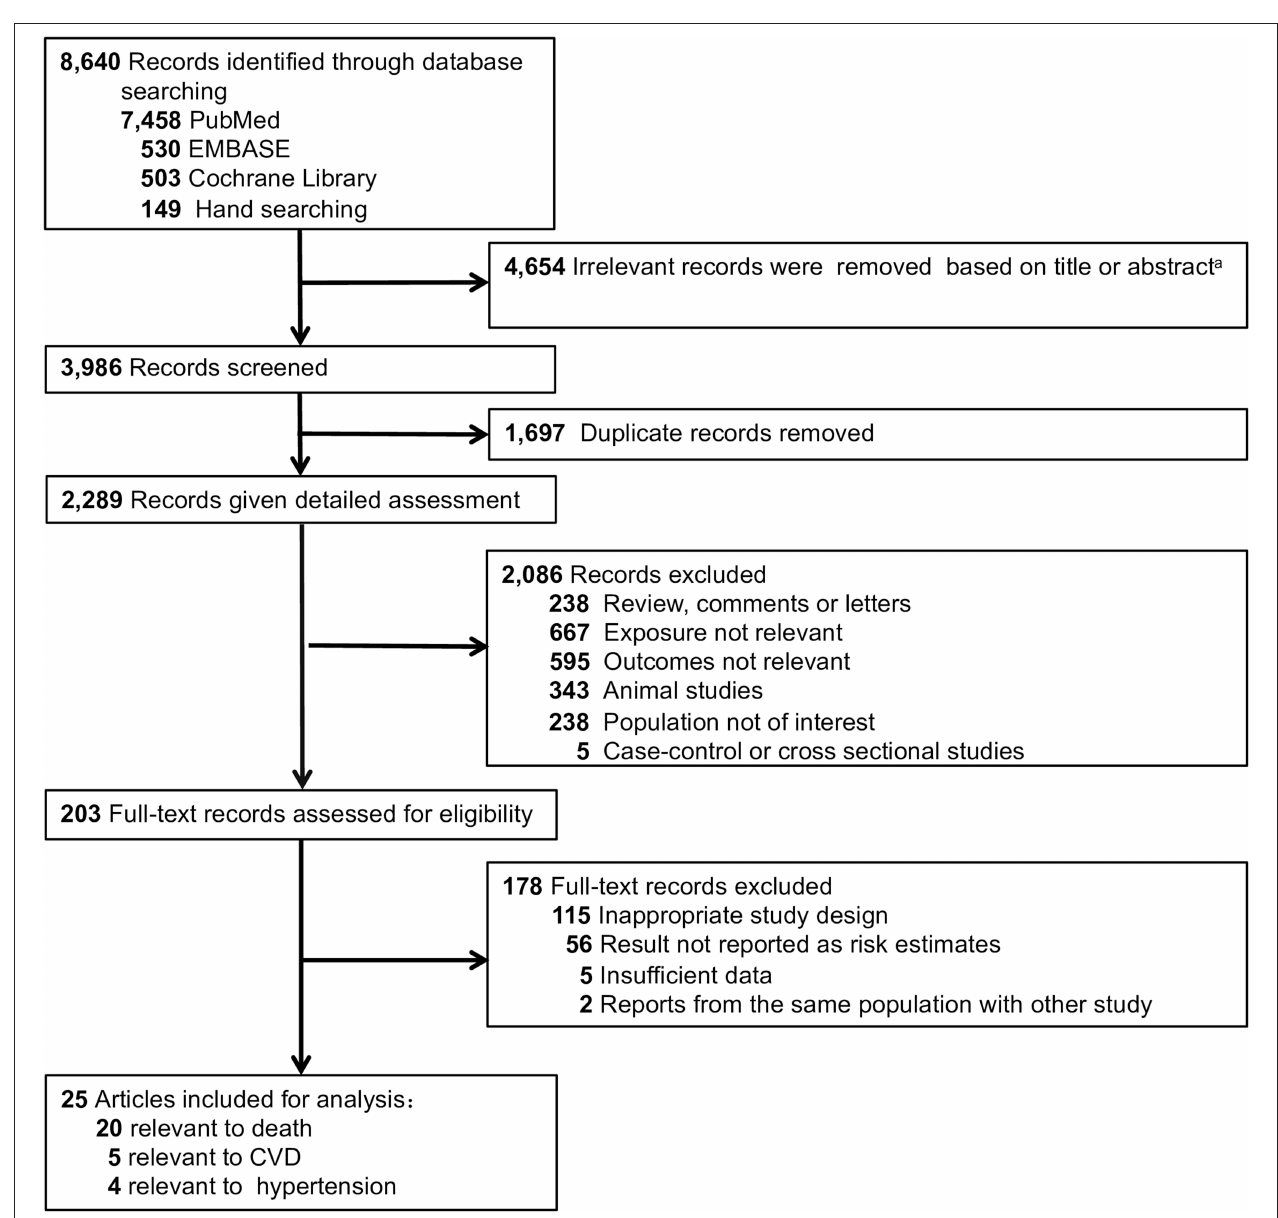
FIGURE 1 | Flow diagram of study selection process. A Exact reasons for exclusions were not documented.